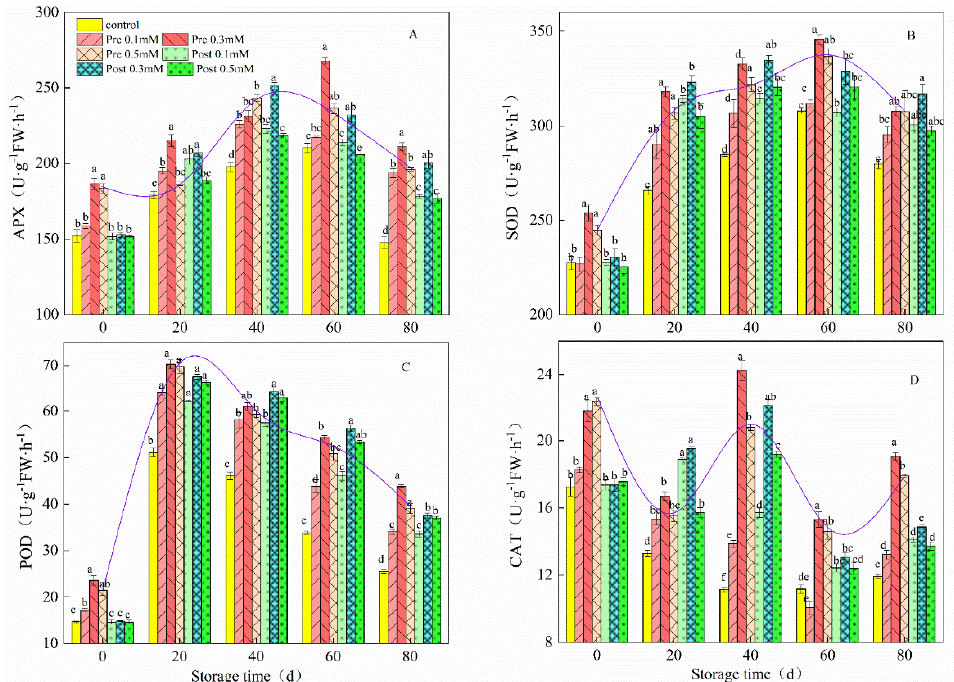
Figure 5. Effect of pre-harvest (Pre) and post-harvest (Post) MeJA treatments on APX ( A ), SOD ( B ), POD ( C ) and CAT ( D ) in lemons in storage at 7–10 ◦ C. Data are the mean ± SE of three replicates of five fruit. Different lowercase letters show significant differences among treatments for each sampling date at p < 0.05 level.